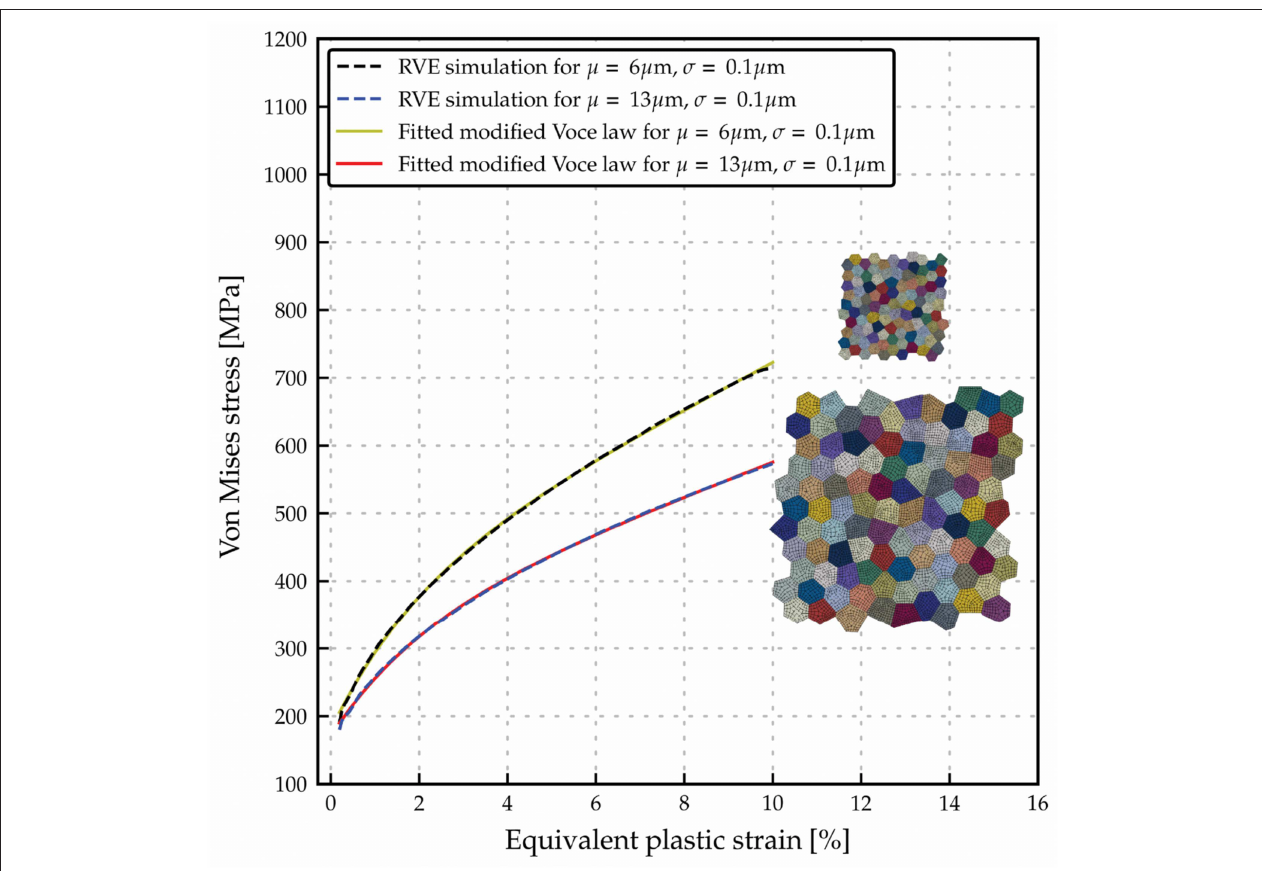
FIGURE 9 | Flow curves comparison between 2 RVEs with different grain size distribution parameter and corresponding flow curves plotted using fitted modified Voce law parameters.